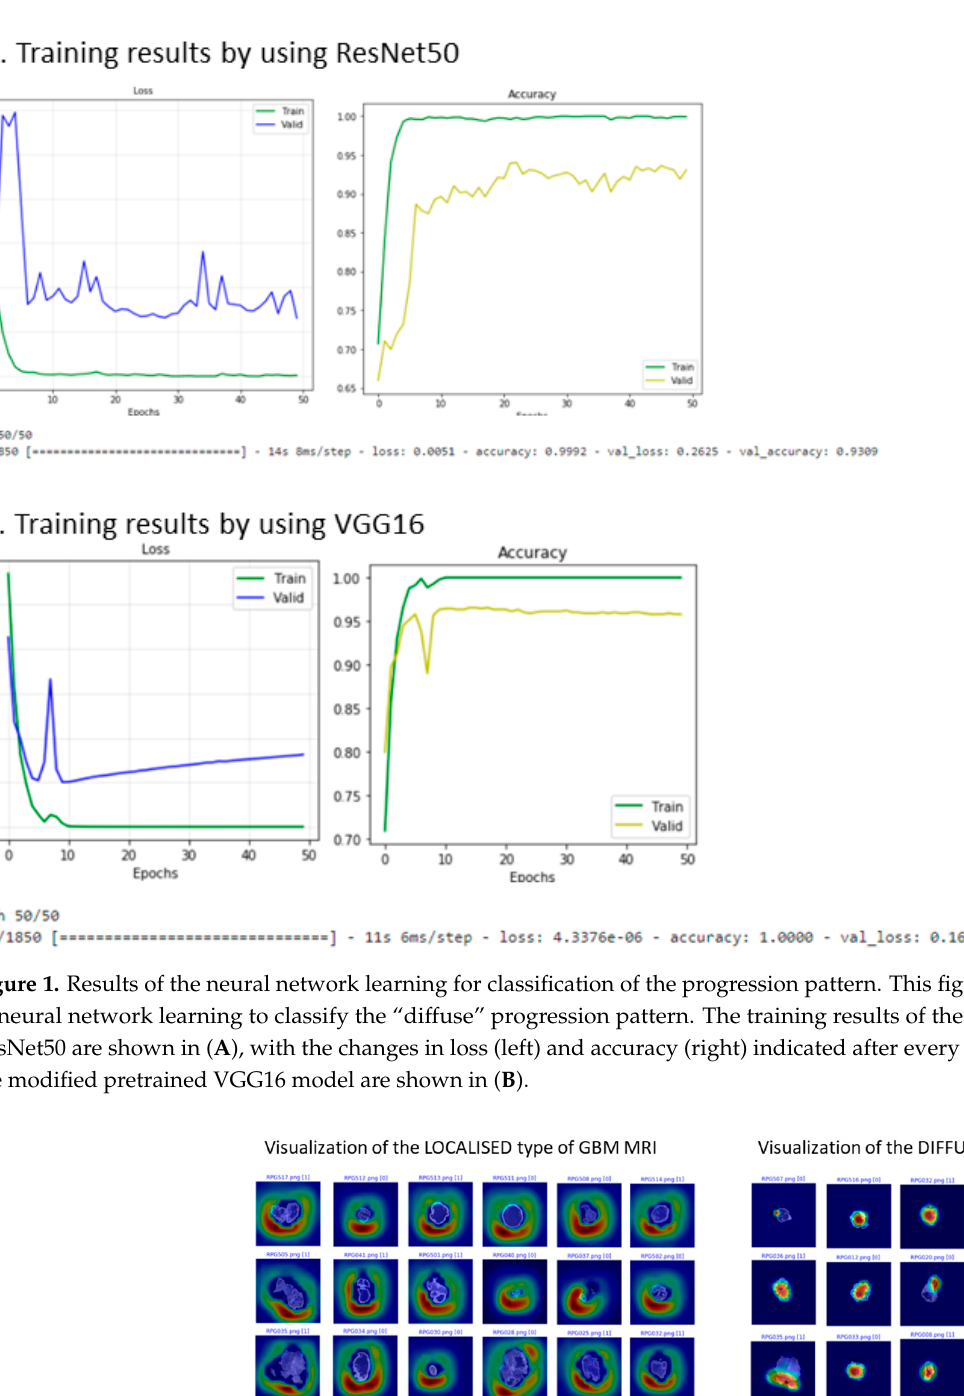
Figure 2. Visualization of the neural network classification result. Figure 2 shows examples of the result obtained by using gradient class activation mapping to demonstrate the visualization of the neural networks. The localized pattern is shown on the left side, and the diffuse pattern is shown on the right side. 4. Discussion In this study, we established a prediction model for the classification of the tumor progression phenotype from preoperative MRI data using a quantitative radiomics ma- chine learning model and convolutional neural network imaging analysis; moreover, we showed the capability of this technique to identify tumors that may progress diffusely.